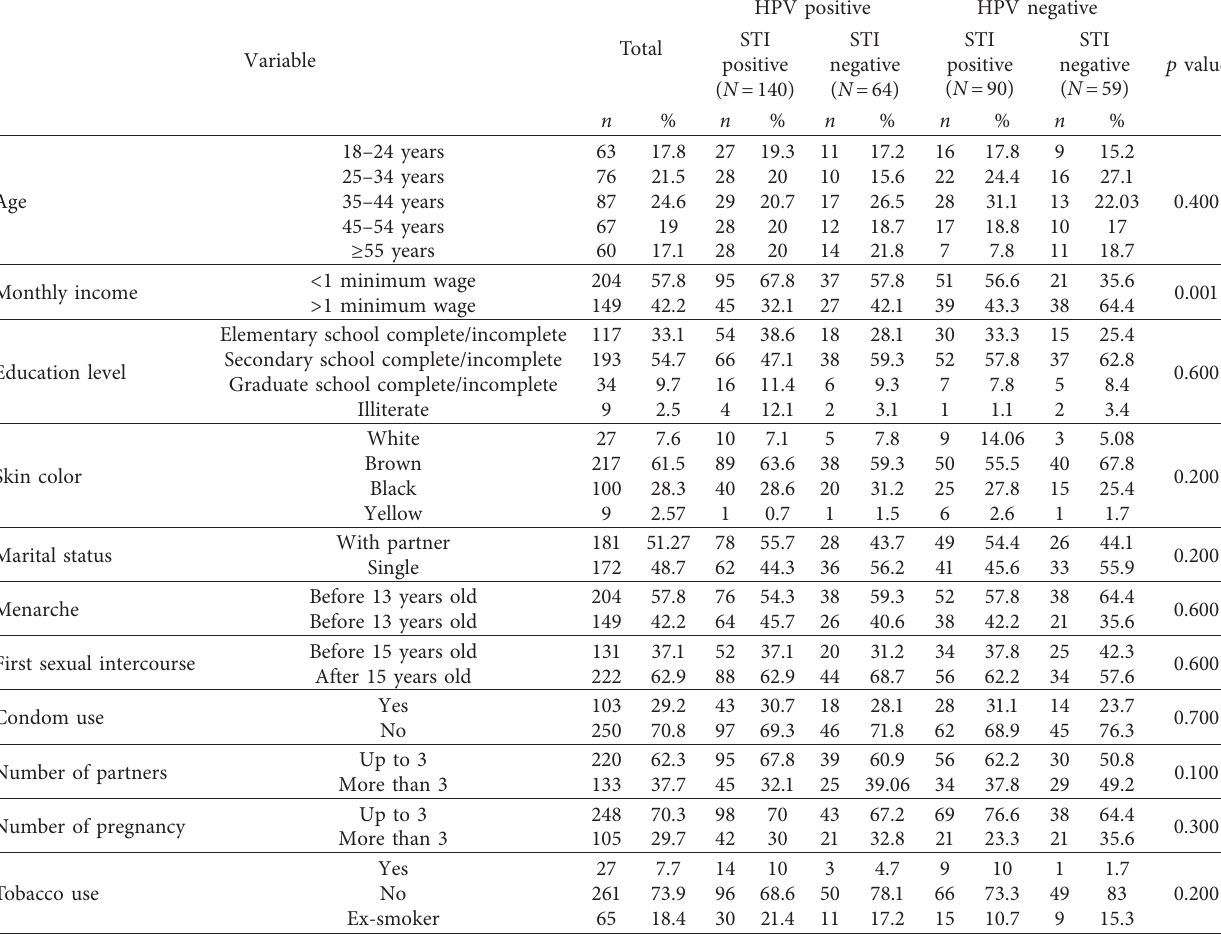
Table 1: Sociodemographic characteristics of the participants according to the presence of HPV and STIs.